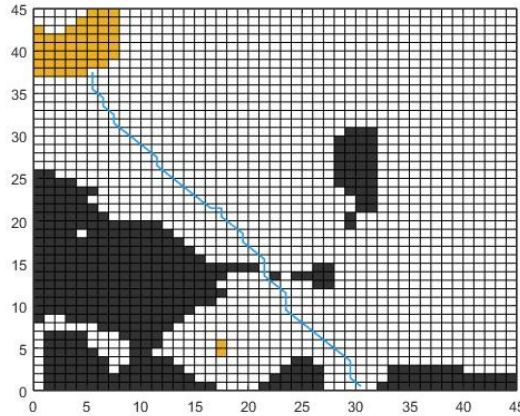
Figure 6. The result of company B.